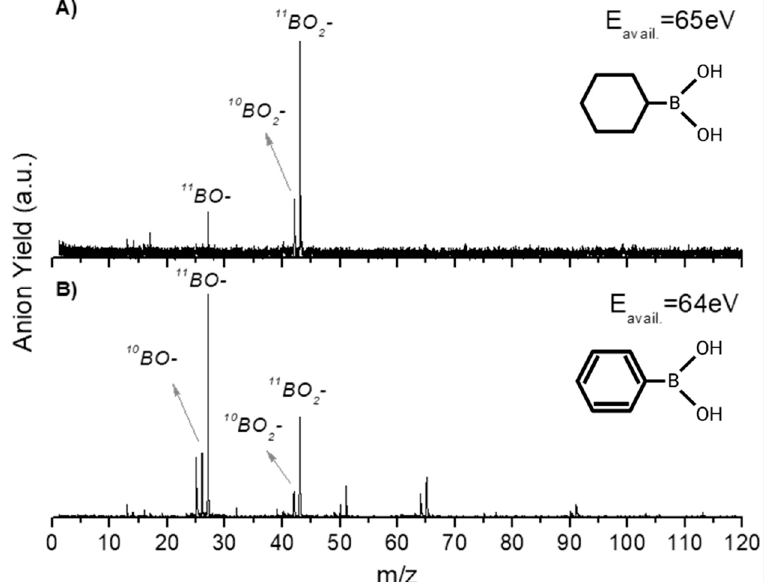
Figure 5. Comparison of time-of-flight negative ions’ mass spectra in neutral potassium collisions with CHBA ( A ) and PBA ( B ) at a 100 eV collision energy (~65 eV available